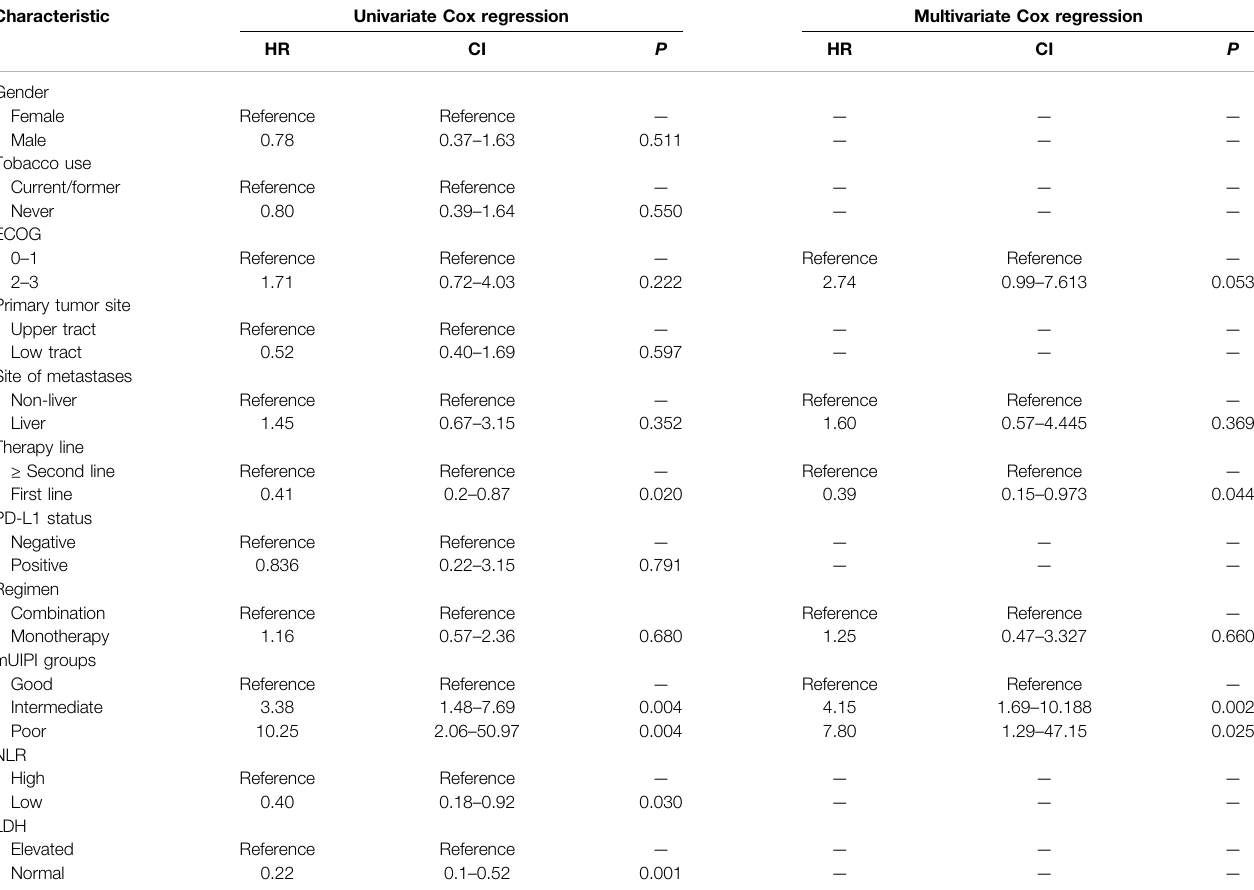
TABLE 4 | Cox proportional hazard regression model of PFS on included patients.